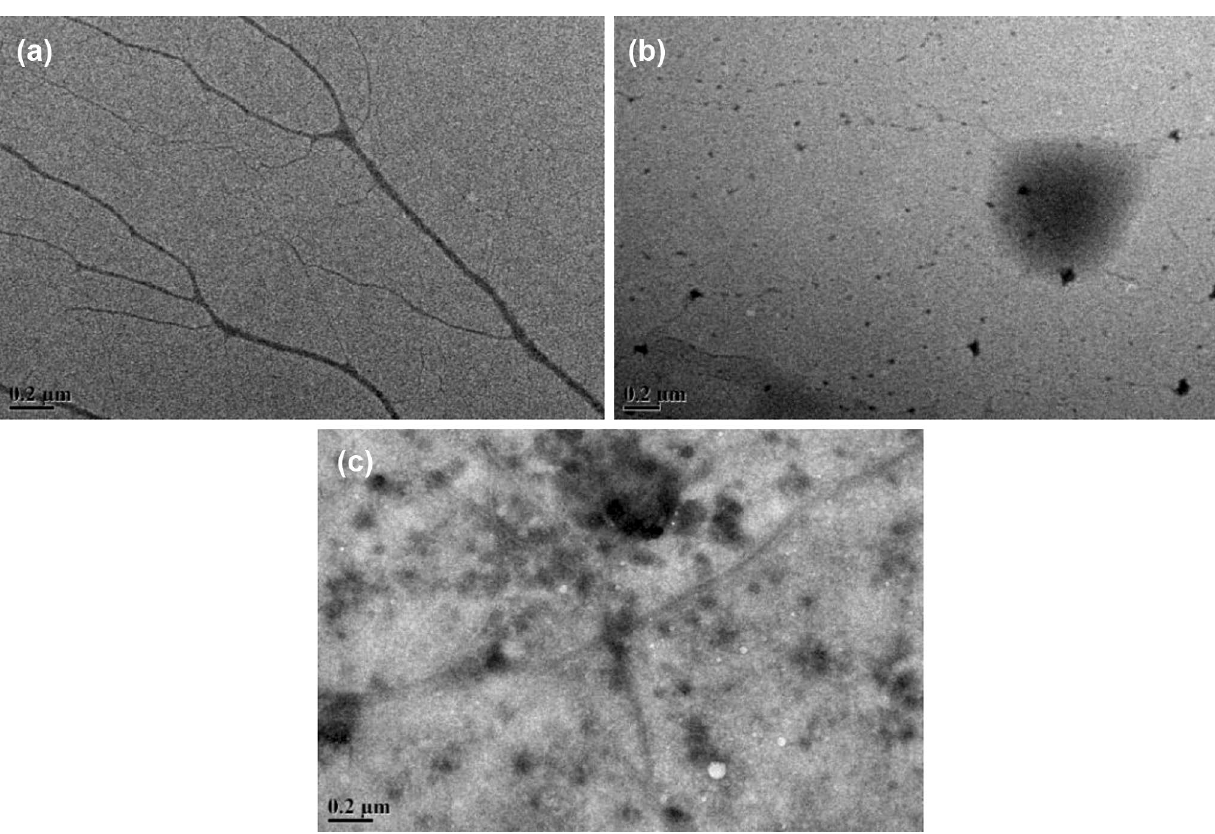
Fig. 9 a TEM image of linear polymer; b TEM image of polymer–surfactant; and c TEM image of HAHPAM